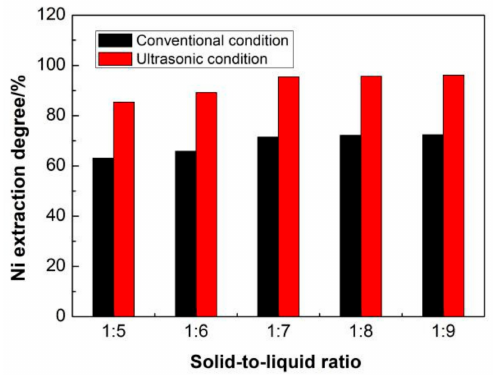
Figure 7. Effect of particle size on Ni extraction degree. Conventional: leaching temperature = 25 ◦ C, mass fraction of sulfuric acid = 15%, particle size = − 150 µ m, stirring speed = 150 rpm, leaching time = 40 min. Ultrasonic: leaching temperature = 25 ◦ C, mass fraction of sulfuric acid = 15%, particle size = − 150 µ m, ultrasonic power = 600 W, leaching time = 40